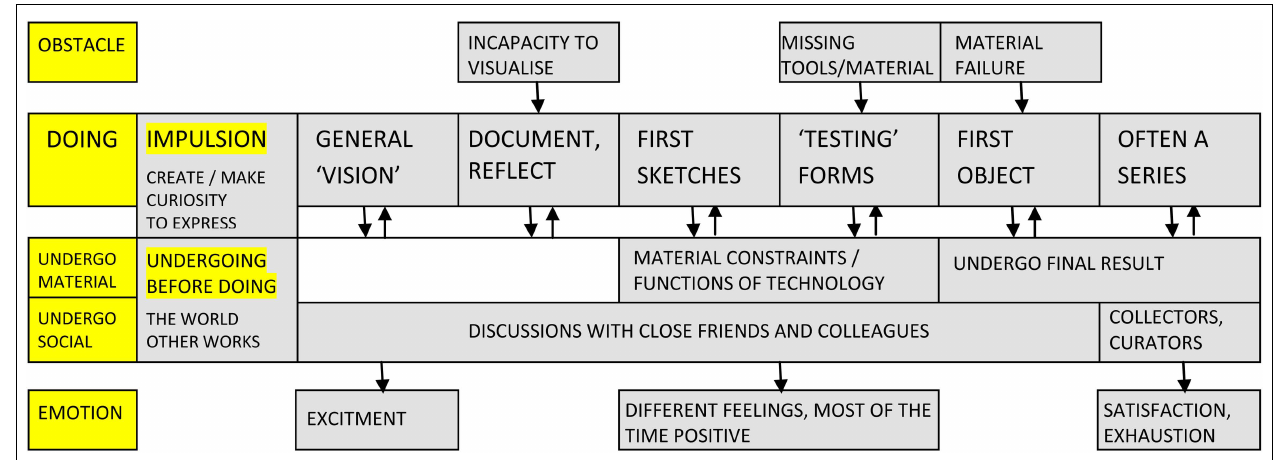
FIGURE 2 | Schematic representation of creative activity in the case of artists.